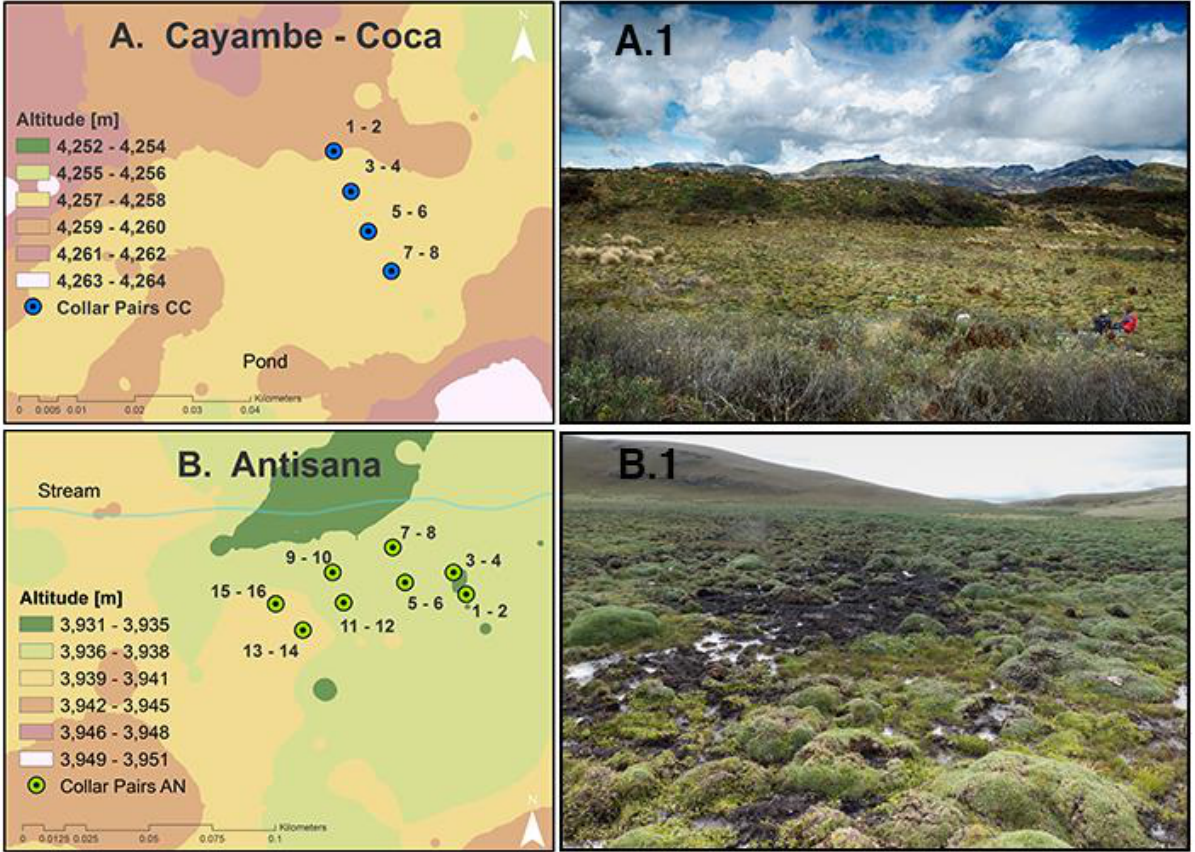
Figure 2. Left: topography of the study sites, Cayambe Coca (A) and Antisana (B). Each circle represents a collar pair. Right: photographs of the study sites Cayambe Coca (A.1) and Antisana (B.1) with vegetation dominated by cushion plants. There is evidence of cattle disturbance at